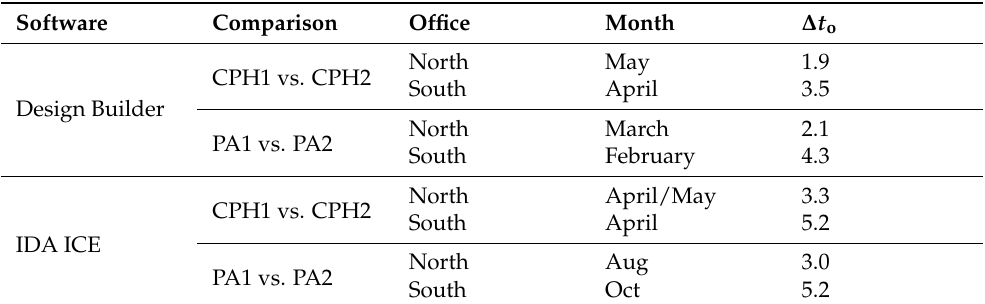
Table 2. Maximum value of Δt o (operative temperature difference) in °C between scenario 1 and scenario 2 for each software and location.